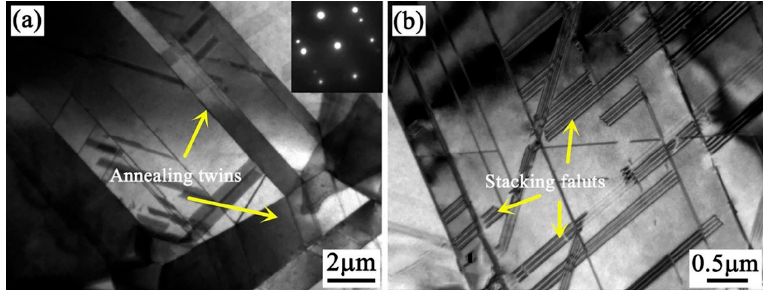
Figure 6. TEM micrographs of the experimental steel before deformation at 25 °C ( ε = 0).